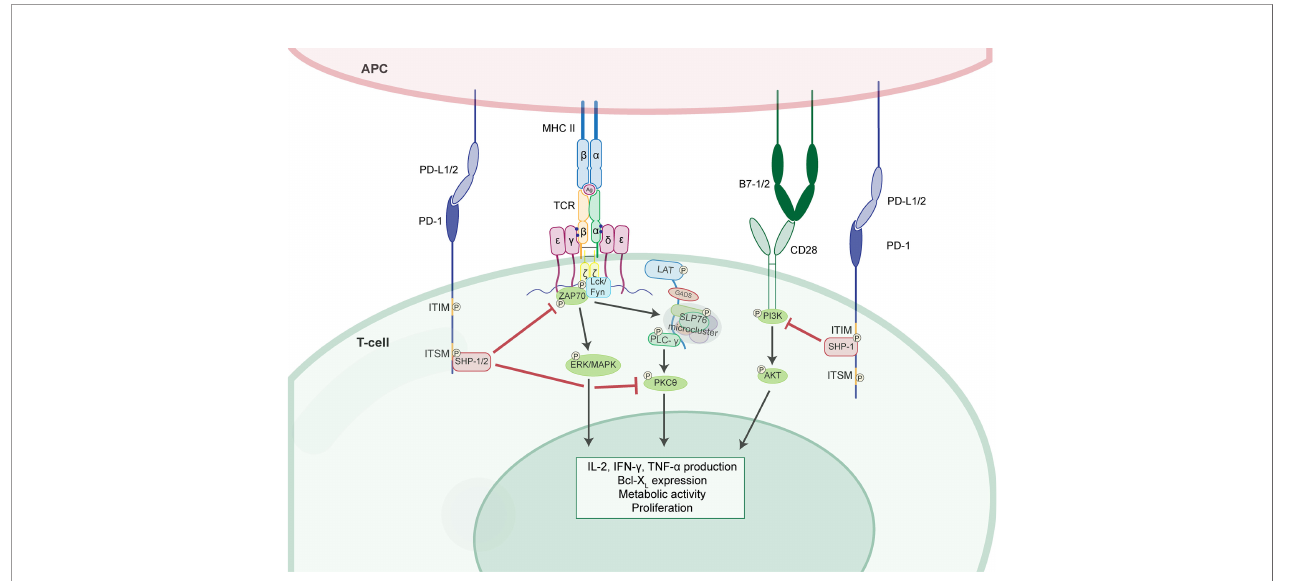
FIGURE 1 | PD-1 suppresses T-cell activation by inhibiting several kinase pathways. T-cell activation occurs when the TCR binds the antigen (Ag) presented by MHC II. This fi rst signal results in ZAP70, Lck, and Fyn recruitment to the CD3- z chain proximal to the TCR. The fi rst signal promotes the ERK/MAPK and PKC- q activation. The second signal occurs when CD28 binds to B7-1/2 and results in PI3K recruitment and downstream AKT pathway activation. PD-1 intrinsically suppresses T-cell activation. Upon interaction with PD-L1/2 the ITSM domain of PD-1 recruits SHP-1/2. Activated SHP-1/2 inhibit ZAP70 and PKC- q phosphorylation. The ITIM domain of PD-1 is also phosphorylated and recruits SHP-1. This activated SHP-1 inhibits PI3K phosphorylation resulting in suppression of the AKT pathway. These mechanisms of PD-1 induced suppression results in reduced cytokine production, metabolic activity, proliferation, and B-cell lymphoma- extra large (Bcl-X L ) mediated